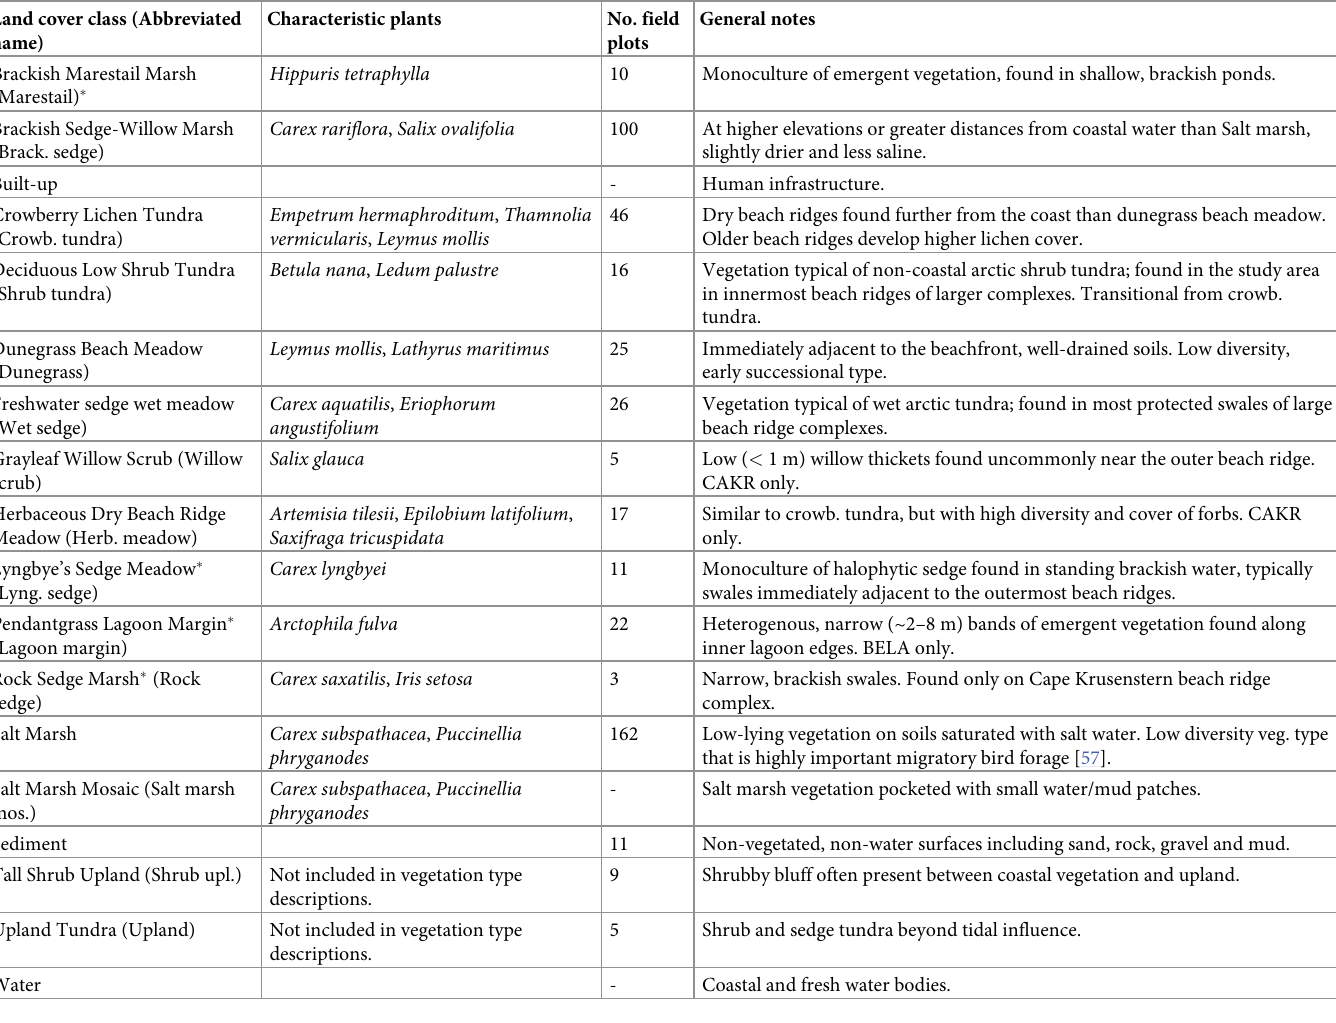
Table 4. Map land cover